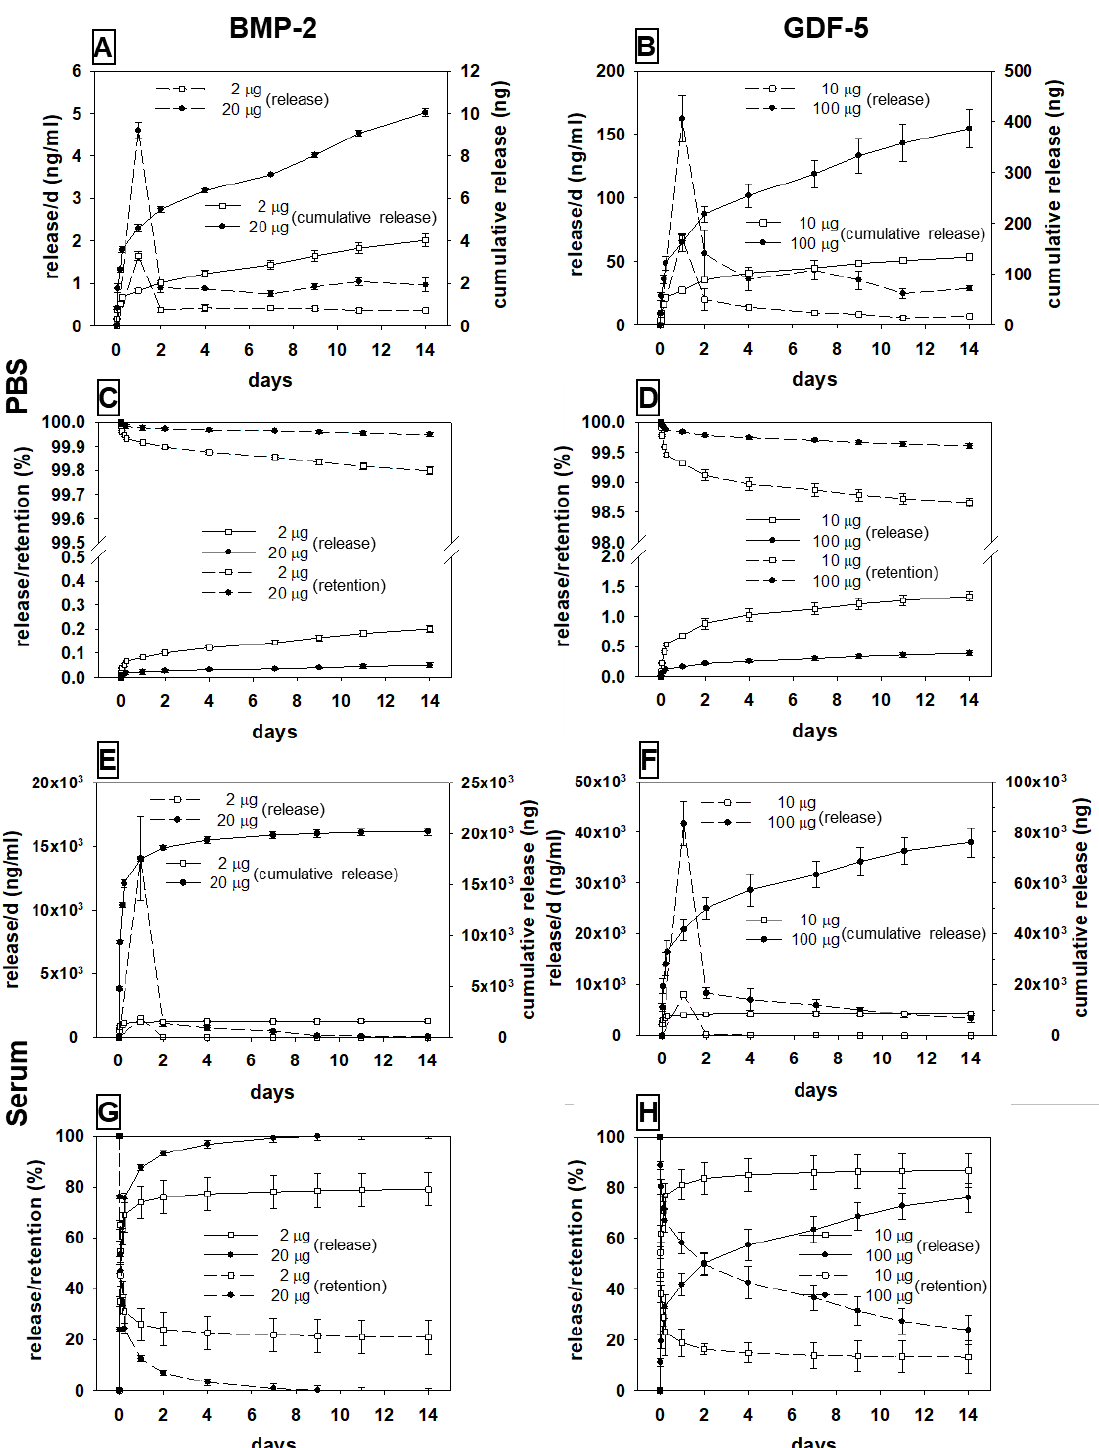
Figure 3. In vitro release per day (respective broken lines; left axis) and cumulative release (respective solid lines; right axis) of the two different doses of BMP-2 (( A ); squares for 2 µ g, circles for 20 µ g) or GDF-5 (( B ); squares for 10 µ g, circles for 100 µ g) from the therapeutically applied hydroxyapatite (HA) particles in PBS; release and retention (%) of BMP-2 ( C ) or GDF-5 ( D ) in PBS; in vitro release per day and cumulative release of BMP-2 ( E ) or GDF-5 ( F ) from the therapeutically applied HA particles in sheep serum; release and retention (%) of BMP-2 ( G ) or GDF-5 ( H ) in sheep serum.